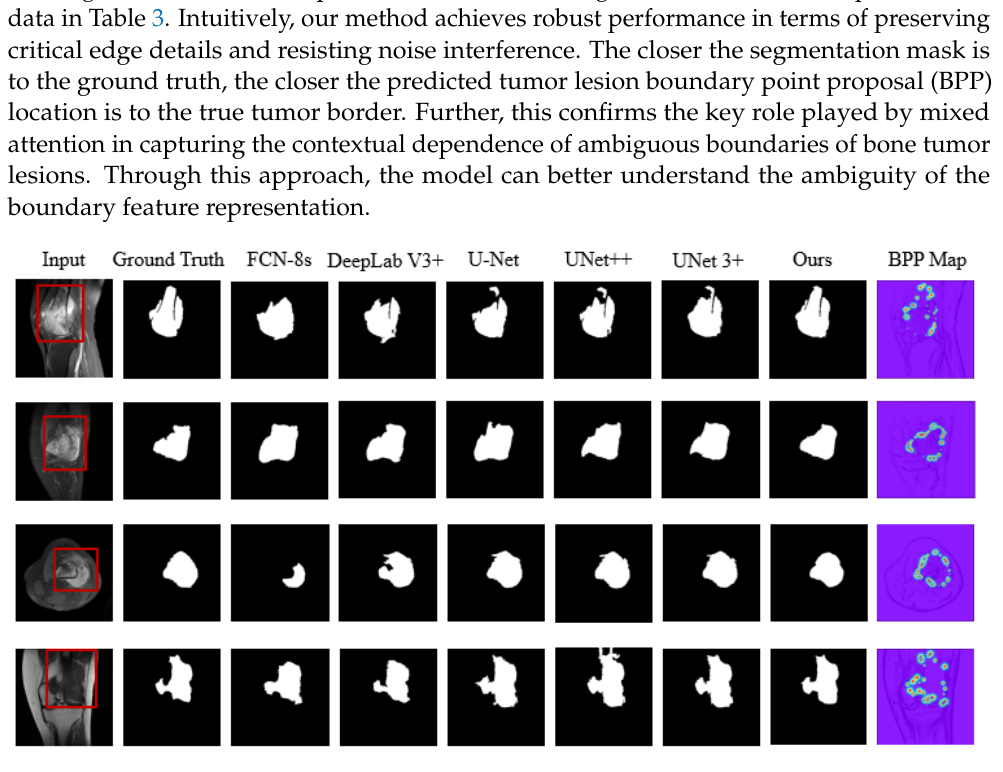
Figure 8. The influence of the three backbones on the overall segmentation performance of SEAGNET according to different metrics. It is necessary to evaluate the effects of alignment sampling on the performance of model segmentation since it is the most essential step in the basic task of feature extraction.